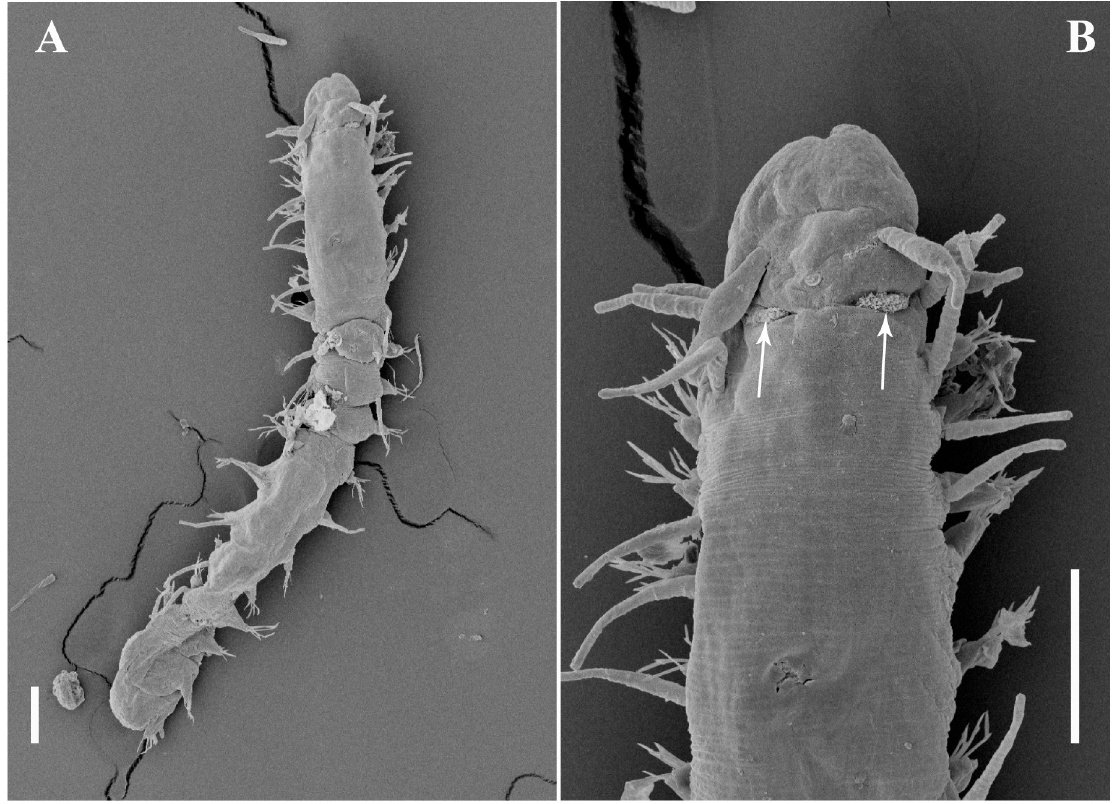
Fig 8. Salvatoria marielleae n. sp., paratype 3 (MZUSP 3593), SEM. (A). Incomplete specimen, dorsal view; (B). Anterior body, dorsal view. Arrows pointing to ciliated nuchal organs. Scale bars: A–B, 100 μ m.